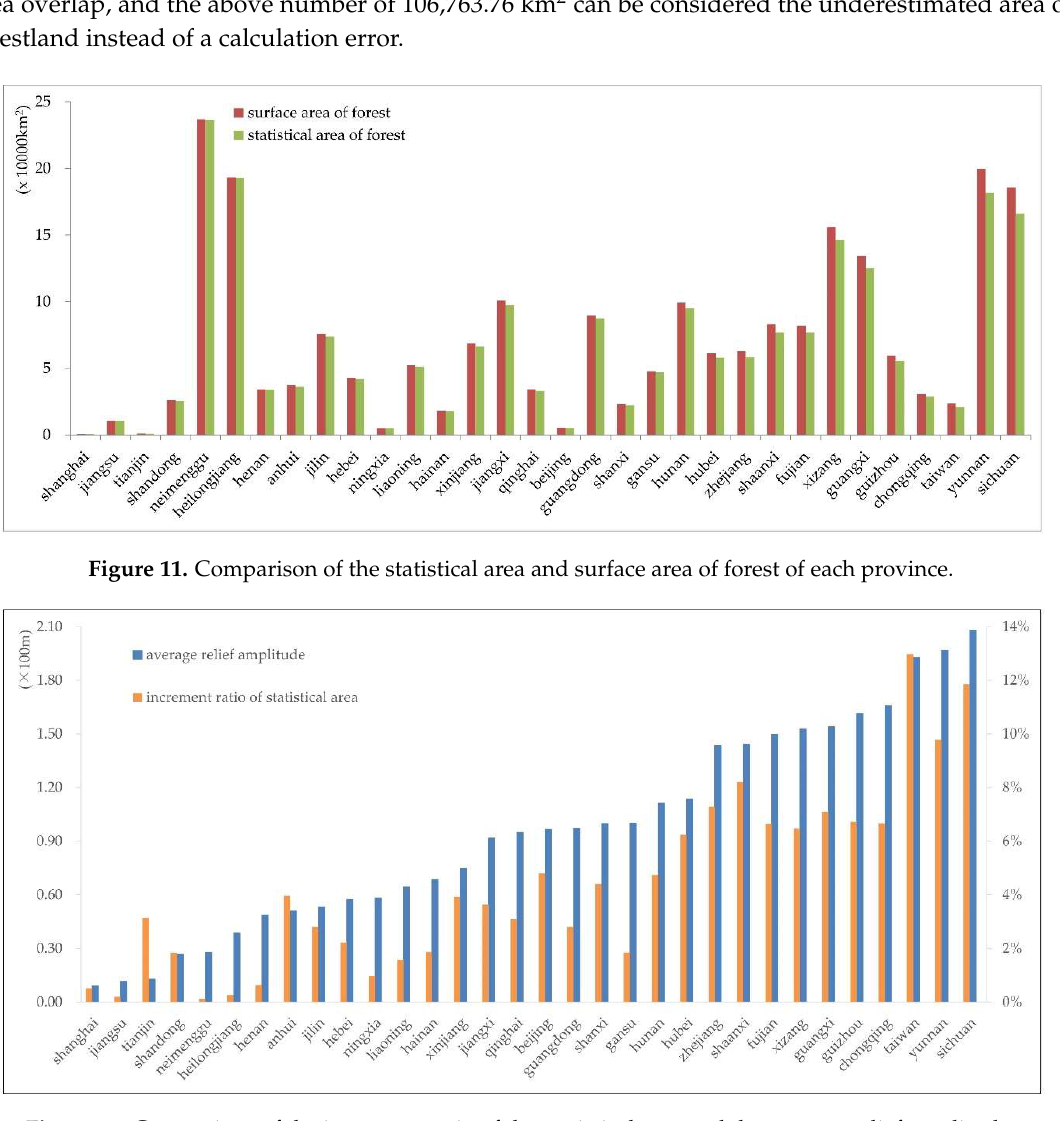
Figure 12. Comparison of the increment ratio of the statistical area and the average relief amplitude.